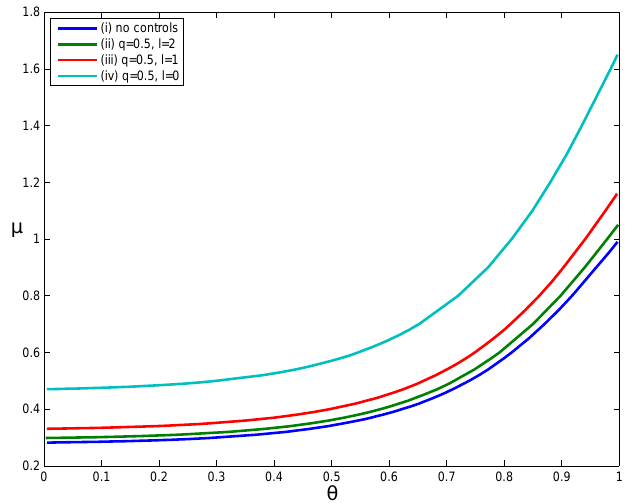
Figure 3. The impact of delay in voluntary